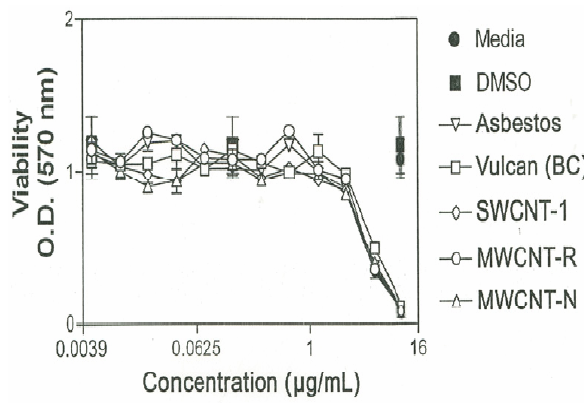
Figure 6: Cytotoxicity (murine macrophage cell relative viability) versus concentration (µg/mL) for carbonaceous nanoparticulate aggregates and chrysotile asbestos nanotube